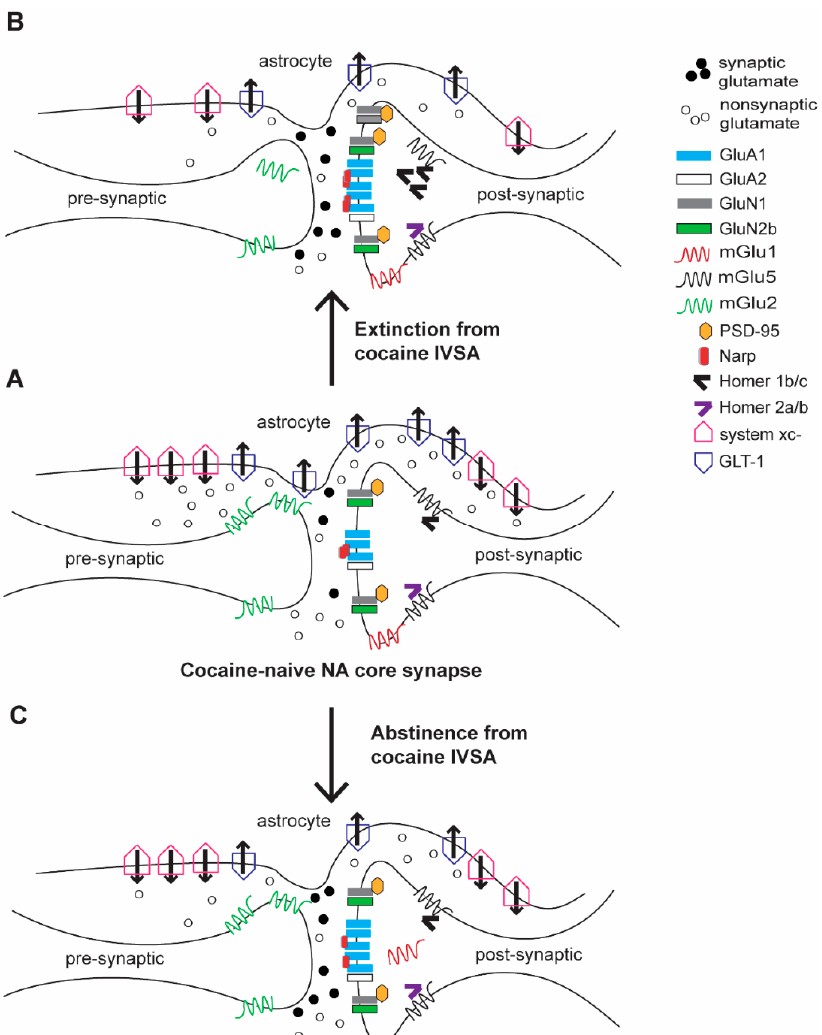
Figure 1. Molecular adaptations in glutamate receptors, transporters, and signaling molecules in the NA core synapse after extinction and abstinence from cocaine. ( A ) Prototypical glutamate synapse in a cocaine-naïve animal. ( B ) Adaptations after extinction training differ from those after abstinence ( C ), with different effects on GluN1, mGlu5, mGlu1, and several scaffolding proteins. The GluN1 subunit of the NMDA receptor has been found to be increased in H and S1 fractions after extinction, but not abstinence [61–63]. Thus, this represents one protein